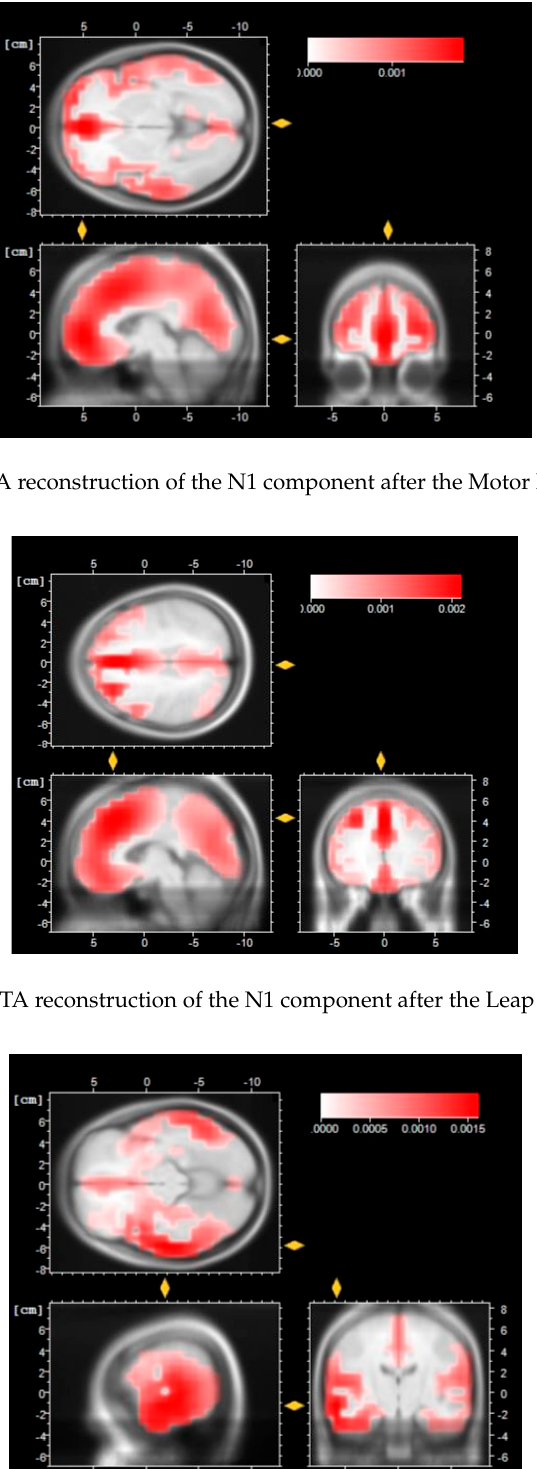
Figure 8. Grand average-matching ERP: black line represents the response of the task after motor imagery training; the red line represents the response after the task of leap motion training, and the blue line represents the response after haptic training. This matching is the ERP trend of the three conditions during the task in all channels recorded.